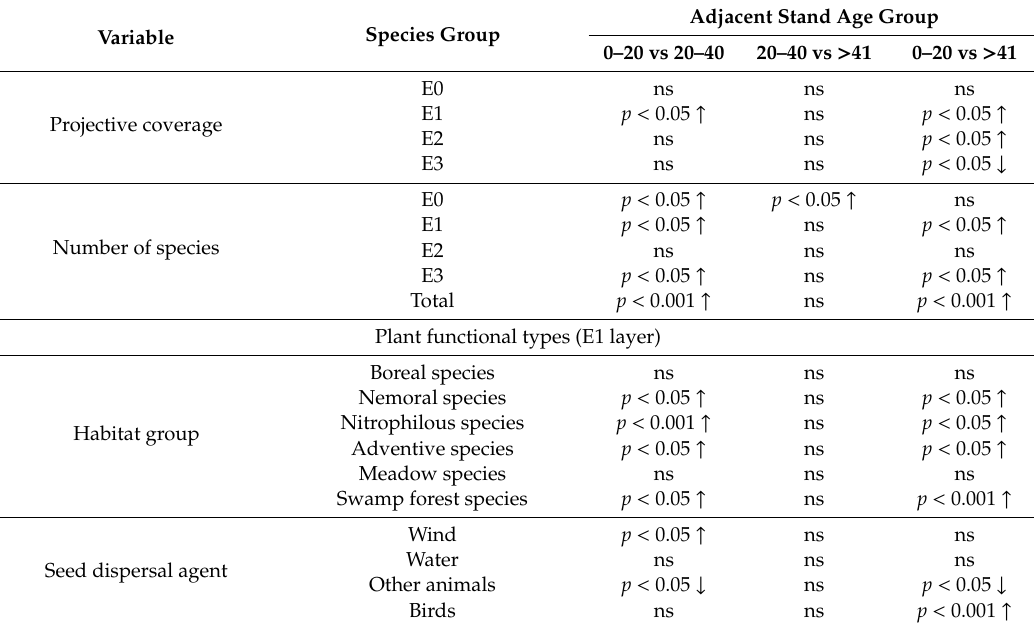
Table 1. Summary of ANOVA results ( n = 90) for species projective coverage, number of species and plant functional types (including habitat groups, seed dispersal agents, plant strategy groups, Raunkiaer life history forms) and environmental factors.